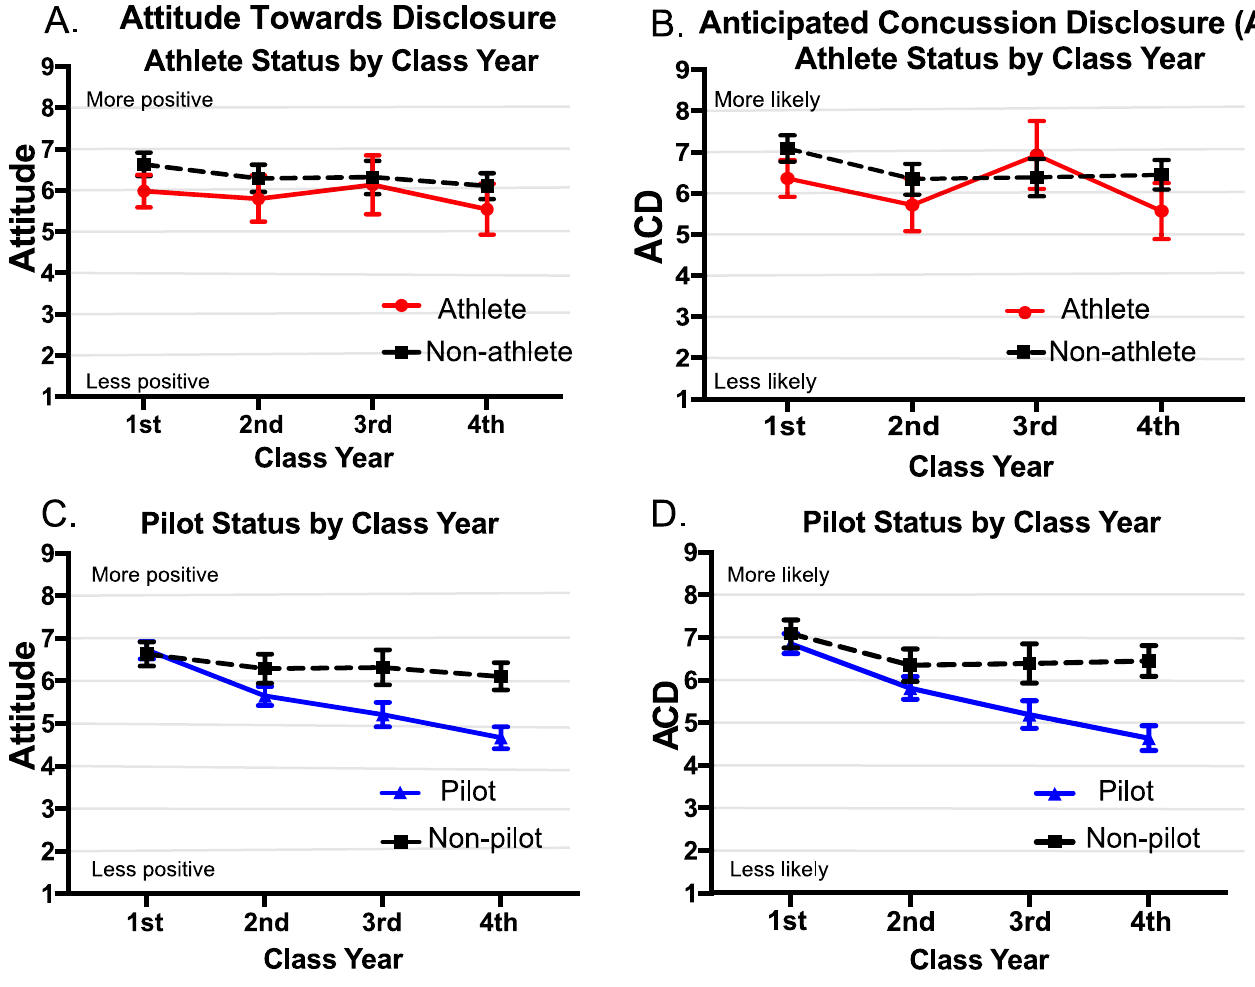
Fig 1. (a) Shows Attitude towards disclosure and (b) ACD (Mean and 95% CI error bars for all figures) for Athletes and Non-athletes across four class years. Future pilots were excluded from analyses. (c) Shows Attitude towards disclosure and (d) ACD for future Pilots and Non-pilots across four class years. Intercollegiate athletes were excluded from